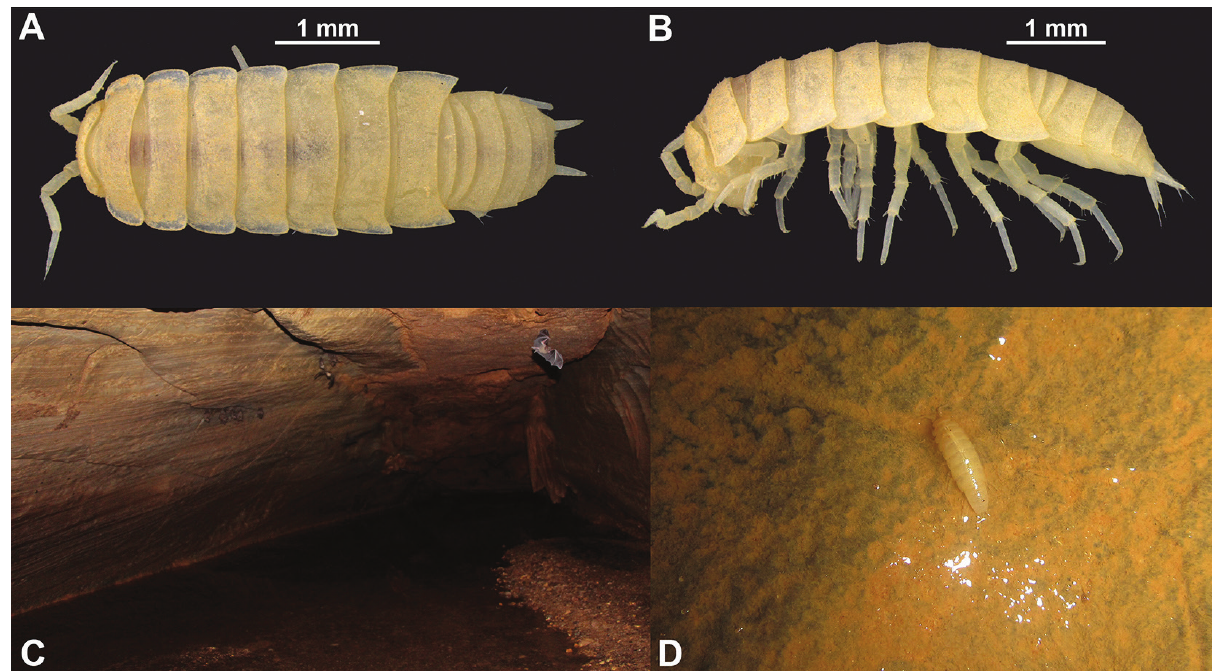
Figure 7. Xangoniscus odara n. sp. (male paratype). A, habitus, dorsal view; B, habitus, lateral view; C, Lapa do Cipó cave, collecting site; D, specimen in